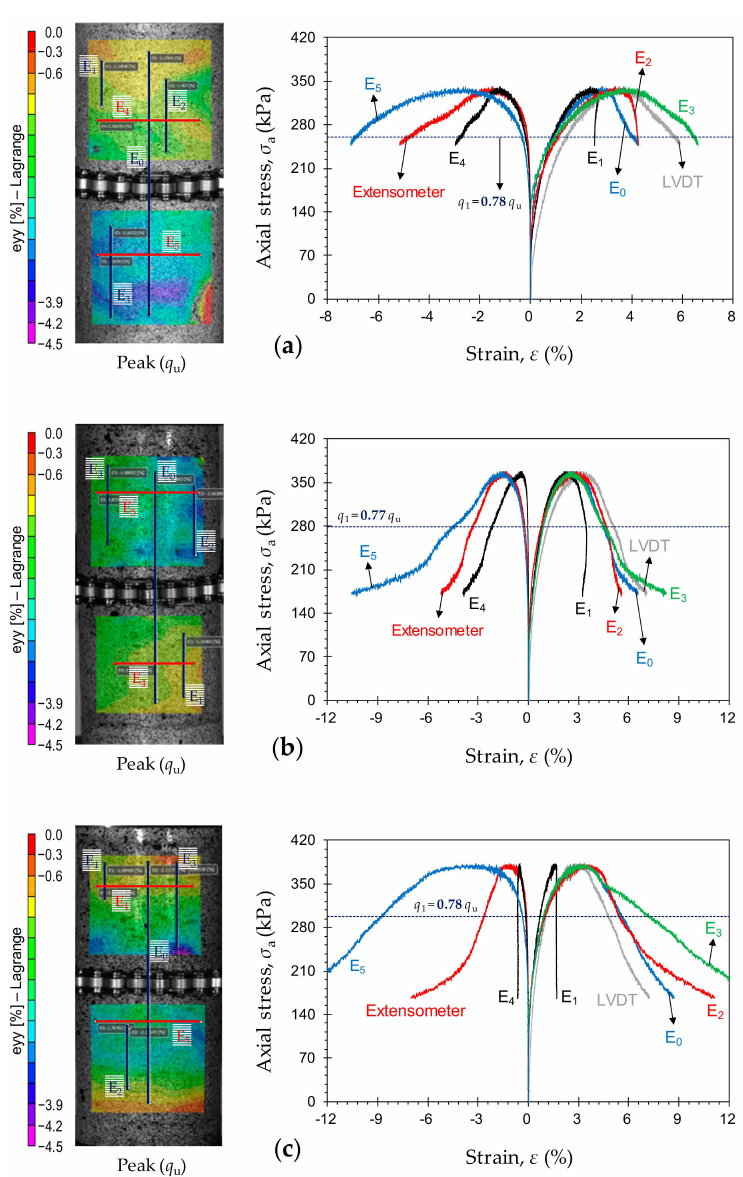
Figure 11. Typical stress–strain curves, obtained by means of various measurement techniques, for the tested samples: ( a ) P 4 F 1 T 14 ; ( b ) P 4 F 2 T 14 ; and ( c ) P 4 F 3 T 14